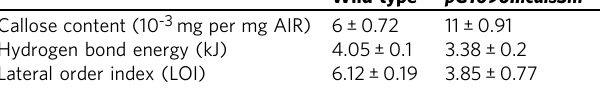
Table 1 Callose concentration, hydrogen bond energy and lateral order index quanti fi ed in alcohol insoluble residues (AIR) from wild type and transgenic pG1090::icals3m plants Wild type a pG1090::icals3m a Callose content (10 -3 mg per mg AIR) 6 ±